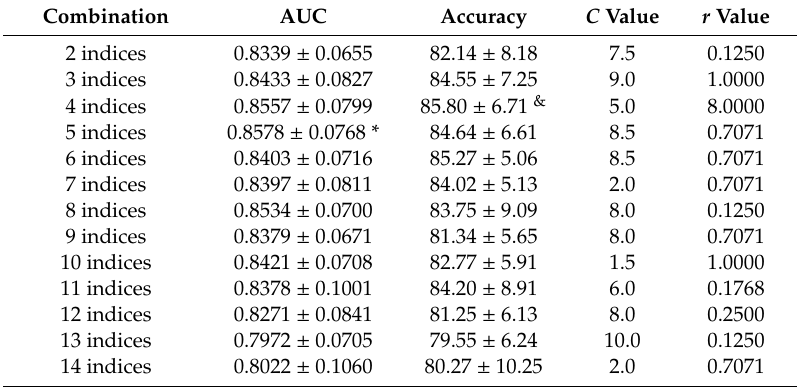
Table 4. Results for the cross-validation for the parameter definition of the support vector machine. The area under the ROC curve and the accuracy are presented as mean ± standard deviation. The optimal values for cost (C) and gamma ( γ ) are also shown. The random threshold was set to 50 for all